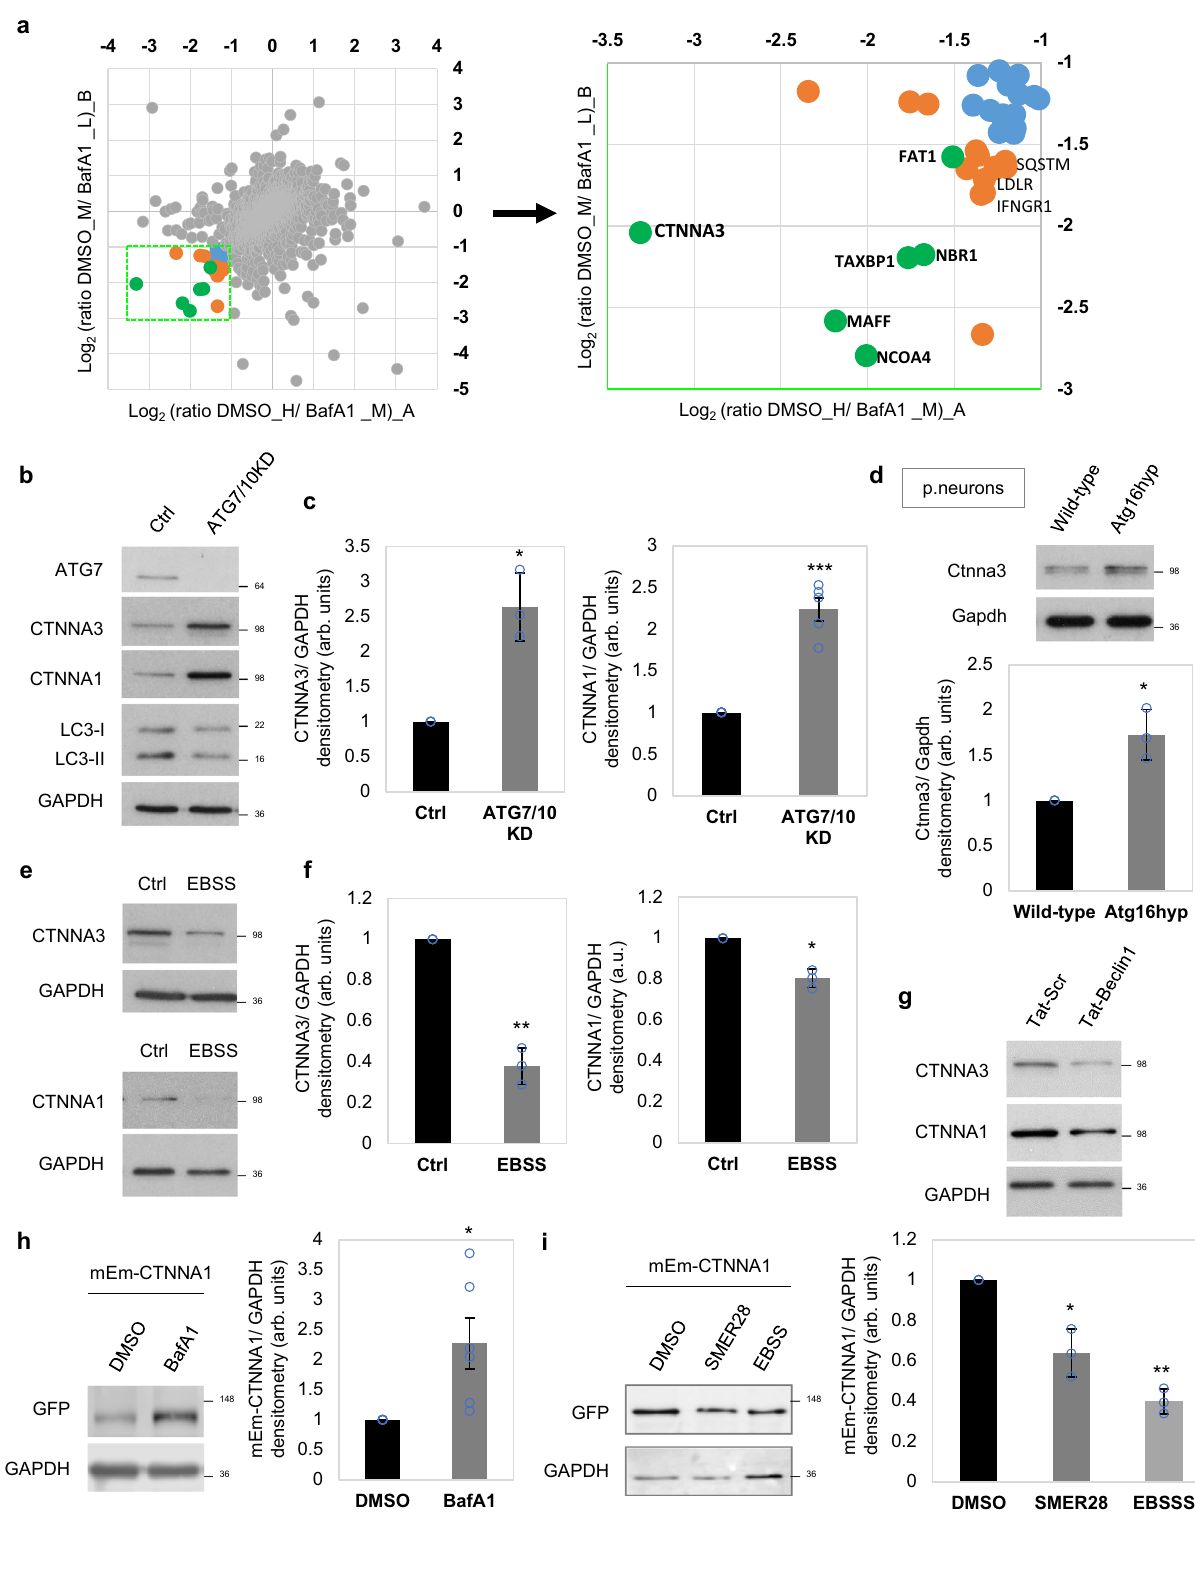
YAP/TAZ activities, were all decreased in MCF10A cells TAZ localisation more markedly than wild-type CTNNA1 when expressing the LIR-defective CTNNA1 mutants to a greater expressed in CTNNA1-depleted cells and CTNNA1 knockdown extent than the wild-type protein. To further con fi rm the role of increased the YAP/TAZ nuclear localisation, which was reduced α -catenins (CTNNA1, CTNNA3) as effectors for the YAP/TAZ upon CTNNA1 (wild-type) re-expression (Fig. 8d). TEAD luci- phenotype caused by autophagy perturbation, MCF10A cells were ferase activity (Fig. 8e), cell proliferation (Fig. 8f, g, Supplemen- initially exposed to ATG7/10 siRNAs for 48 h in order to reach an tary Fig. 19c), and cell area (Fig. 8h), additional correlates of NATURE COMMUNICATIONS| (2021) 12:1703